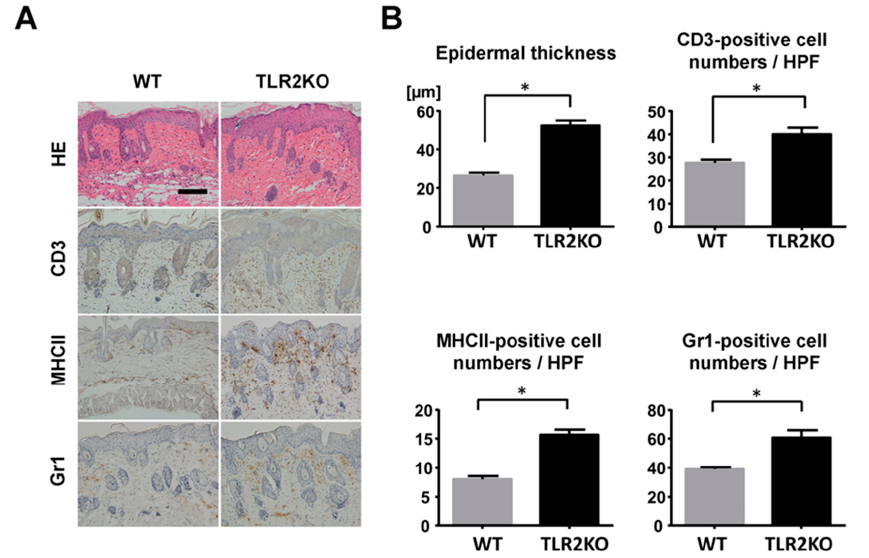
Figure 1. TLR2 deficiency exacerbates psoriasiform dermatitis induced by imiquimod treatment. Shaved back skin and ears of wild-type (WT) and TLR2 knockout (TLR2 KO) mice were topically treated with imiquimod for 5 consecutive days. ( A ) Phenotypical manifestation of WT and TLR2 KO mouse back skin induced by imiquimod application at day 5. ( B ) Disease severity and ear thickness during imiquimod treatment. ** p < 0.01. Clinical scores for disease severity were calculated daily using a scoring system based on the clinical psoriasis area and severity index. Data are presented as mean ± SEM of three independent experiments ( n = 9 for each group). * p < 0.05 versus WT mice with imiquimod application.